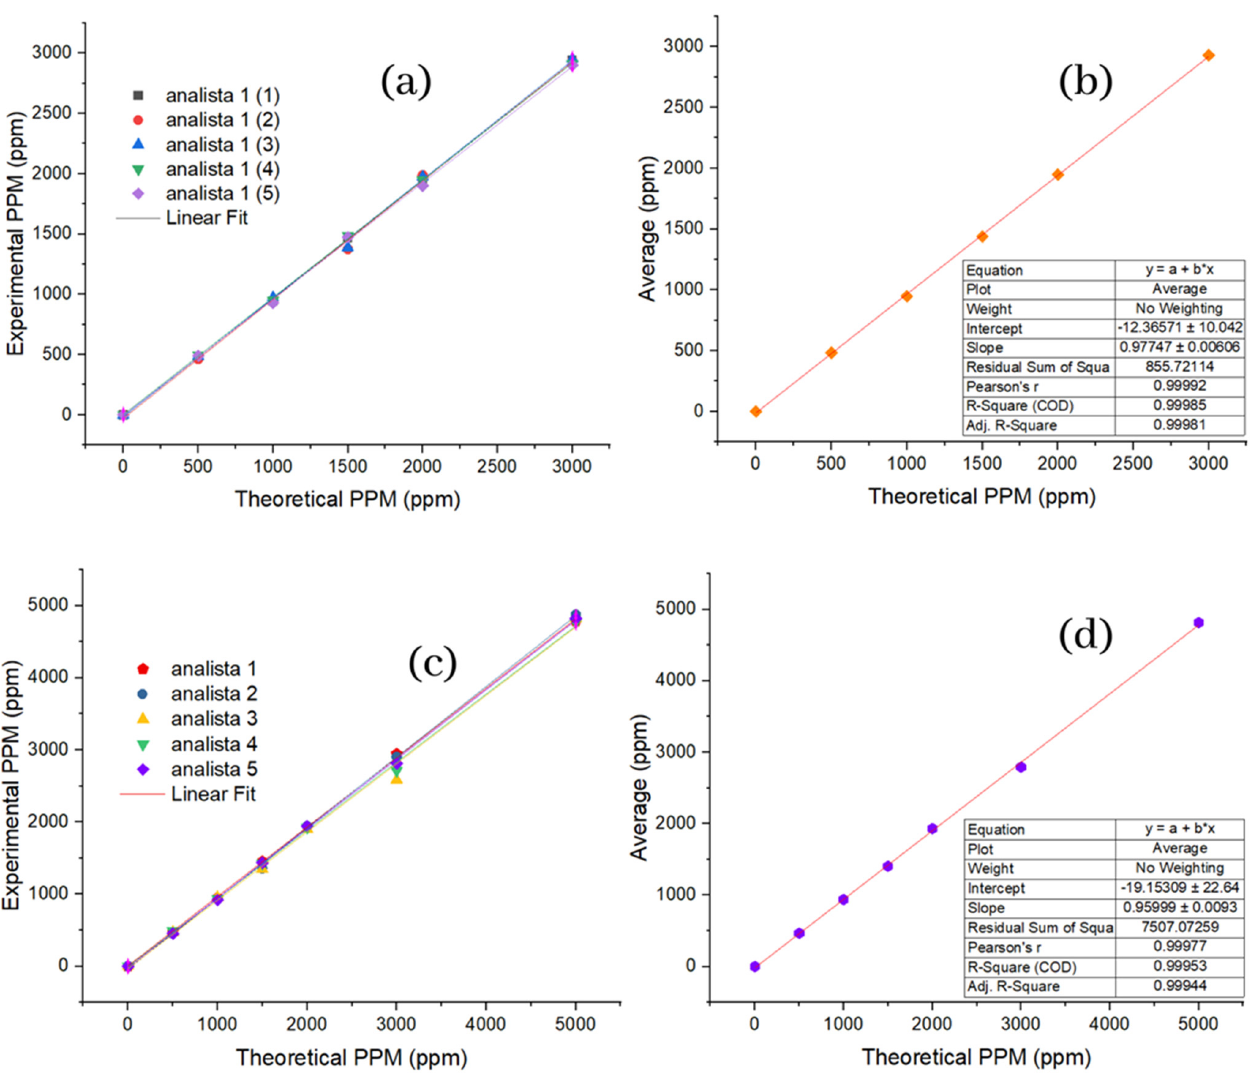
Figure 3. Linearity of interday and intraday measurements. ( a ) Repeatability for standard; ( b ) mean repeatability for standard; ( c ) reproducibility for standard; ( d ) mean reproducibility for standard.